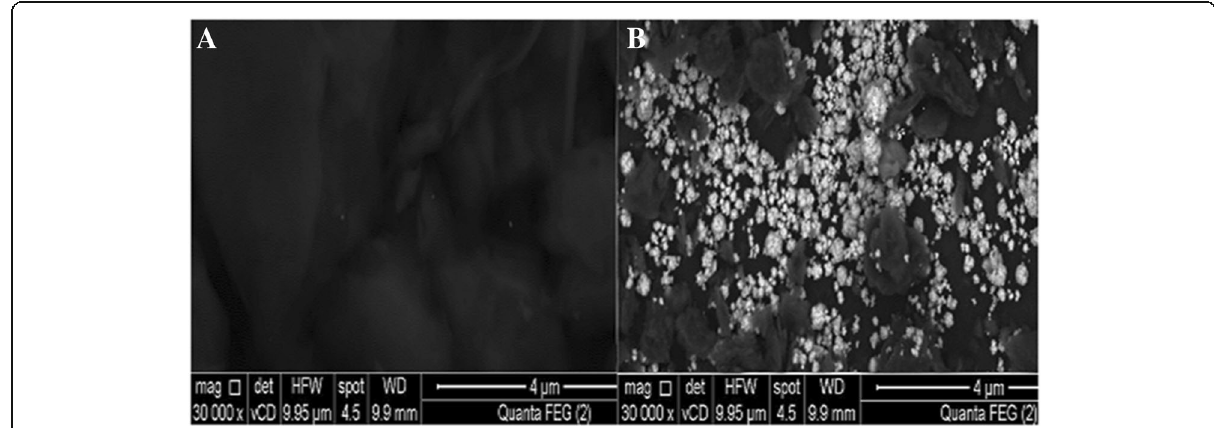
Fig. 1 The SEM image of a bare CPE and b CPE/Fe 2 O 3